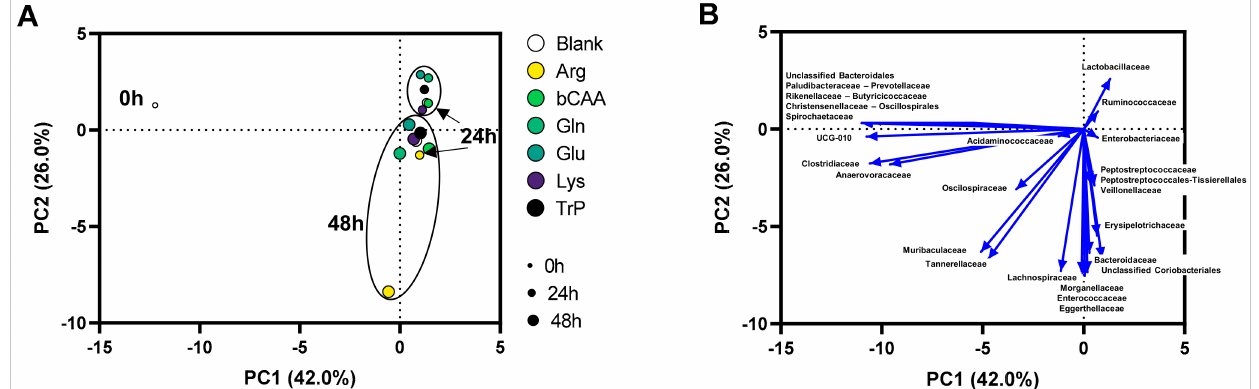
Figure 6. ( A ) PCA based on microbial community composition (family level; absolute values, estimated upon multiplying with total cell counts (cells/mL)) at different time points (0 h, 24 h, and 48 h) during the incubation of porcine colonic microbiota in presence of various amino acids versus an untreated control (blank). ( B ) Loadings of the families on which the PCA was based. The exact absolute levels of the families underlying this clustering provided